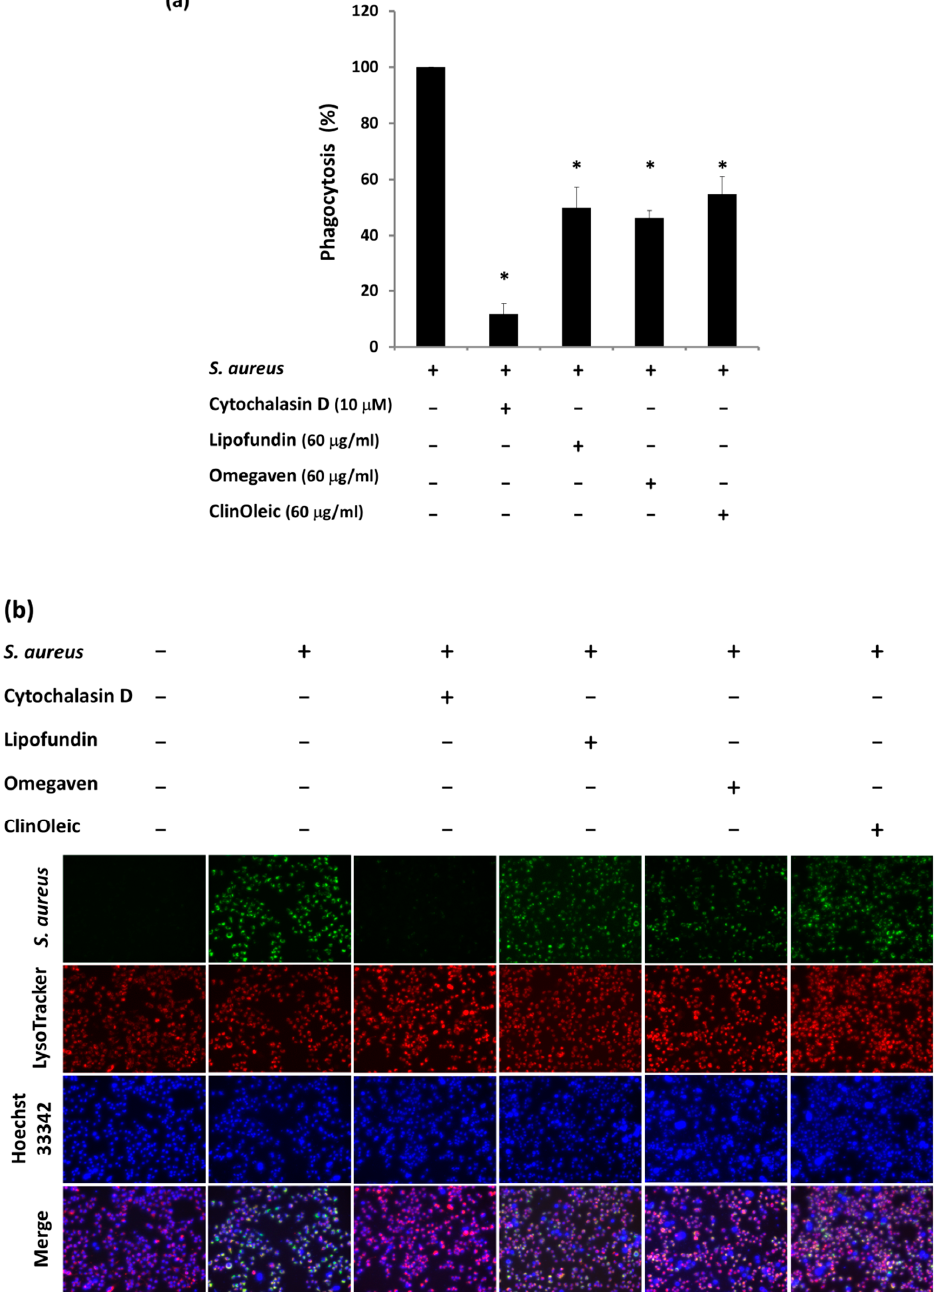
Figure 3. Three lipid emulsions repressed the phagocytosis. ( a ) Applying pHrodo™ Green S. aureus Bioparticles ® conjugate in the absence or presence of indicated reagents to quantify the phagocytosis of mouse RAW264.7 macrophages. Net phagocytosis was calculated by subtracting the fluorescence intensity of the control wells without cells from that of S. aureus bioparticles with or without lipid emulsions and the cytochalasin D (phagocytosis inhibitor, 10 μ M) treatment wells. The phagocytic ability related to the S. aureus bioparticles was determined. The data are presented as the means ± SD of three individual experiments. * Significant differences compared with the positive control by one-way ANOVA followed by Bonferroni test ( p < 0.05). ( b ) Live cell imaging of phagocytosis. The nuclei of RAW264.7 cells that were incubated with green S. aureus bioparticles were stained with Hoechst 33342 (blue). The lysozymes were labeled with LysoTracker (red). The images were obtained by fluorescence microscopy with a 10 ×